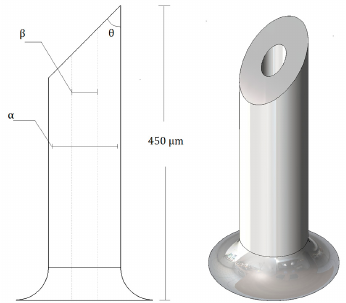
Figure 1. Microneedle CAD Model.